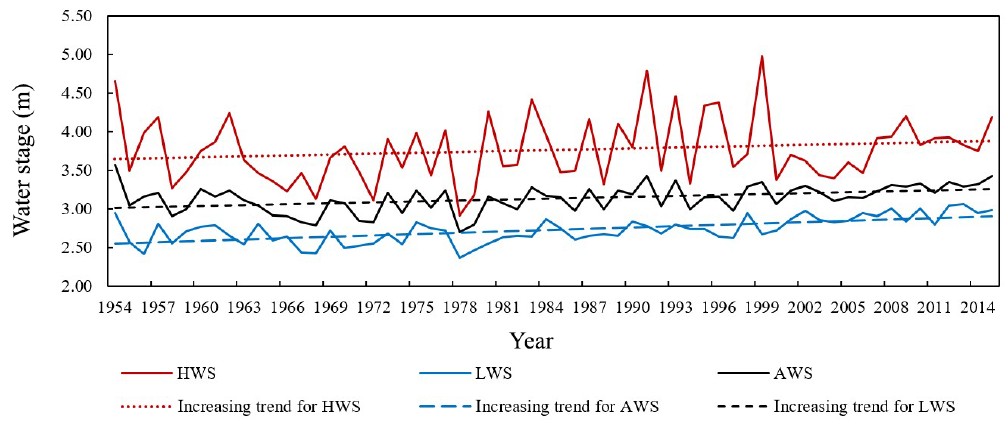
Figure 3. Increasing trend for HWS, LWS, and AWS from 1954 to